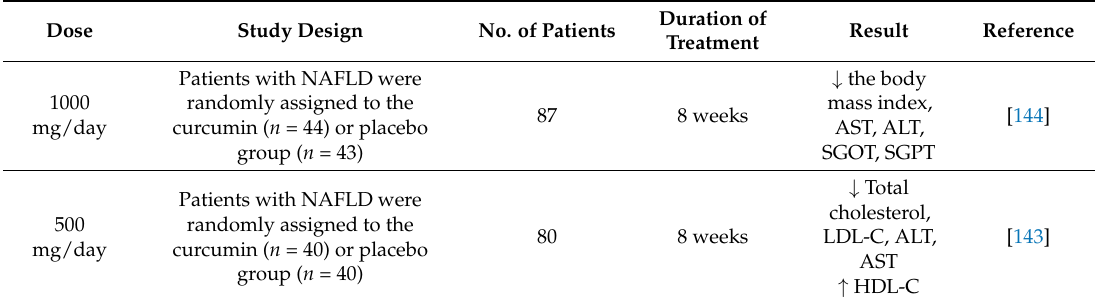
Table 2. Clinical studies of curcumin used in the treatment of oxidative associated liver